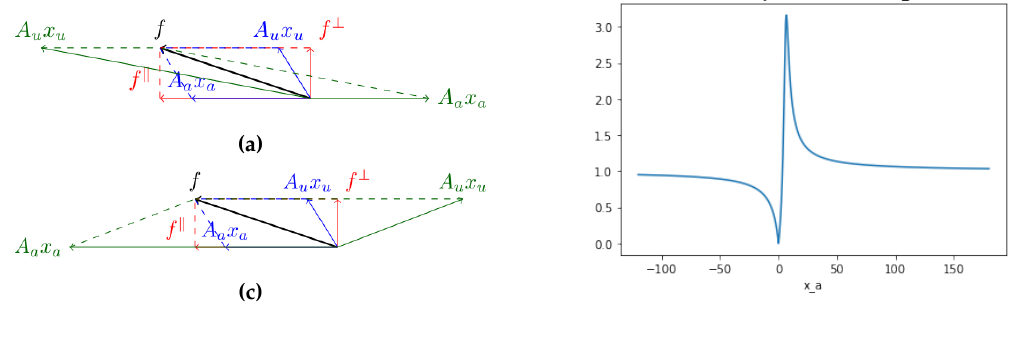
Figure 1. Case n a = 1. ( a ): Case n a = 1, m = n = 2. Solutions with the condition on N f . In the figure: the true decomposition obtained imposing both the conditions (blue), the orthogonal decomposition (red), another possible decomposition (green) that satisfy the same norm condition N f , but different I f ; ( b ): Case n a = 1. Intensity Ratio value w.r.t the norm of the vector A a x a : given a fixed value of Intensity Ratio there can be two solution, i.e. two possible decomposition of f as sum of two vectors with the same Intensity Ratio; ( c ): Case n a = 1, m = n = 2. Solutions with the condition on I f . In the figure: the true decomposition obtained imposing both the conditions (blue), the orthogonal decomposition (red), another possible decomposition (green) with the same intensity ratio I f , but different N f